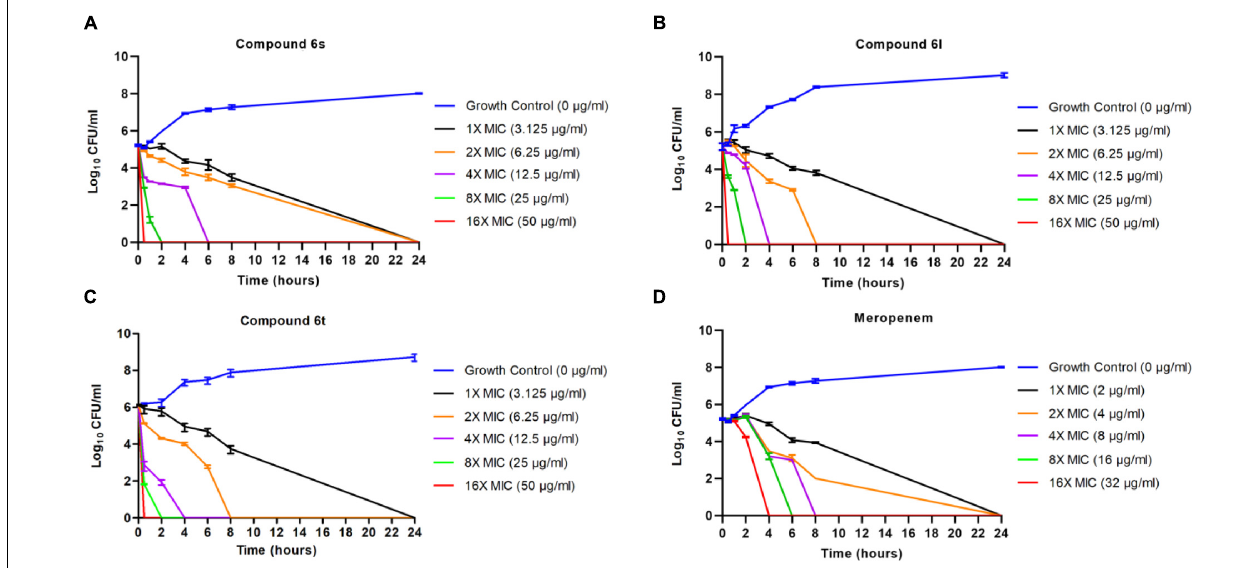
FIGURE 2 | Killing kinetics of the compounds against exponentially growing cells: 10 6 CFU/ml logarithmic phase MRSA-1 cultures were exposed to compounds 6l (A) , 6s (B) , 6t (C) , or control antibiotic meropenem (D) . Viability was determined by serial dilution and CFU counts. Results are the average of 3 independent